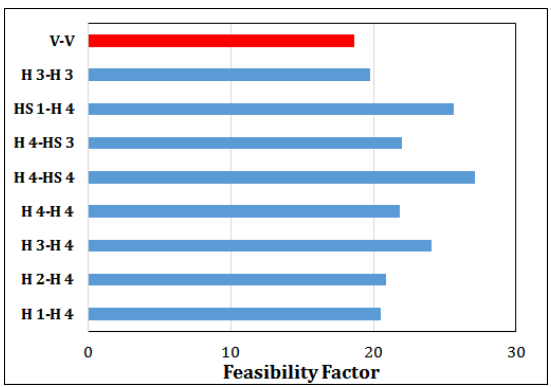
Figure 4. Feasibility factor of all of the combinations belonging to Category B.